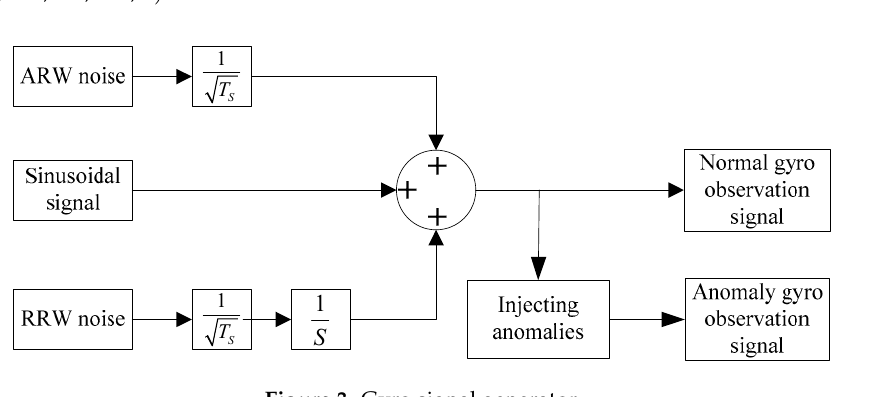
Figure 3. Gyro signal generator.